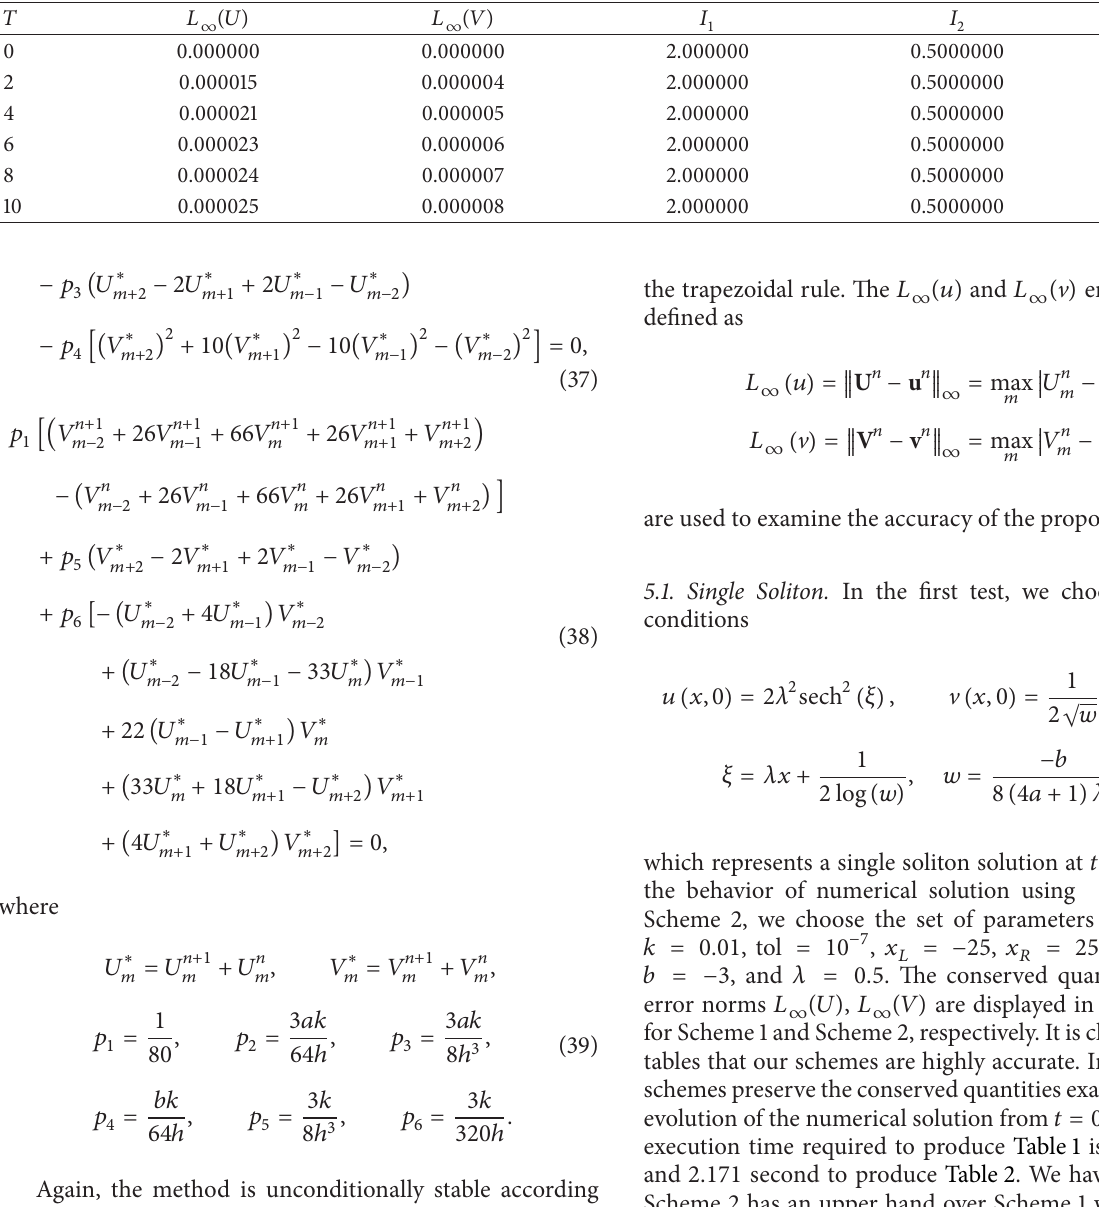
Table 1: Petrov-Galerkin